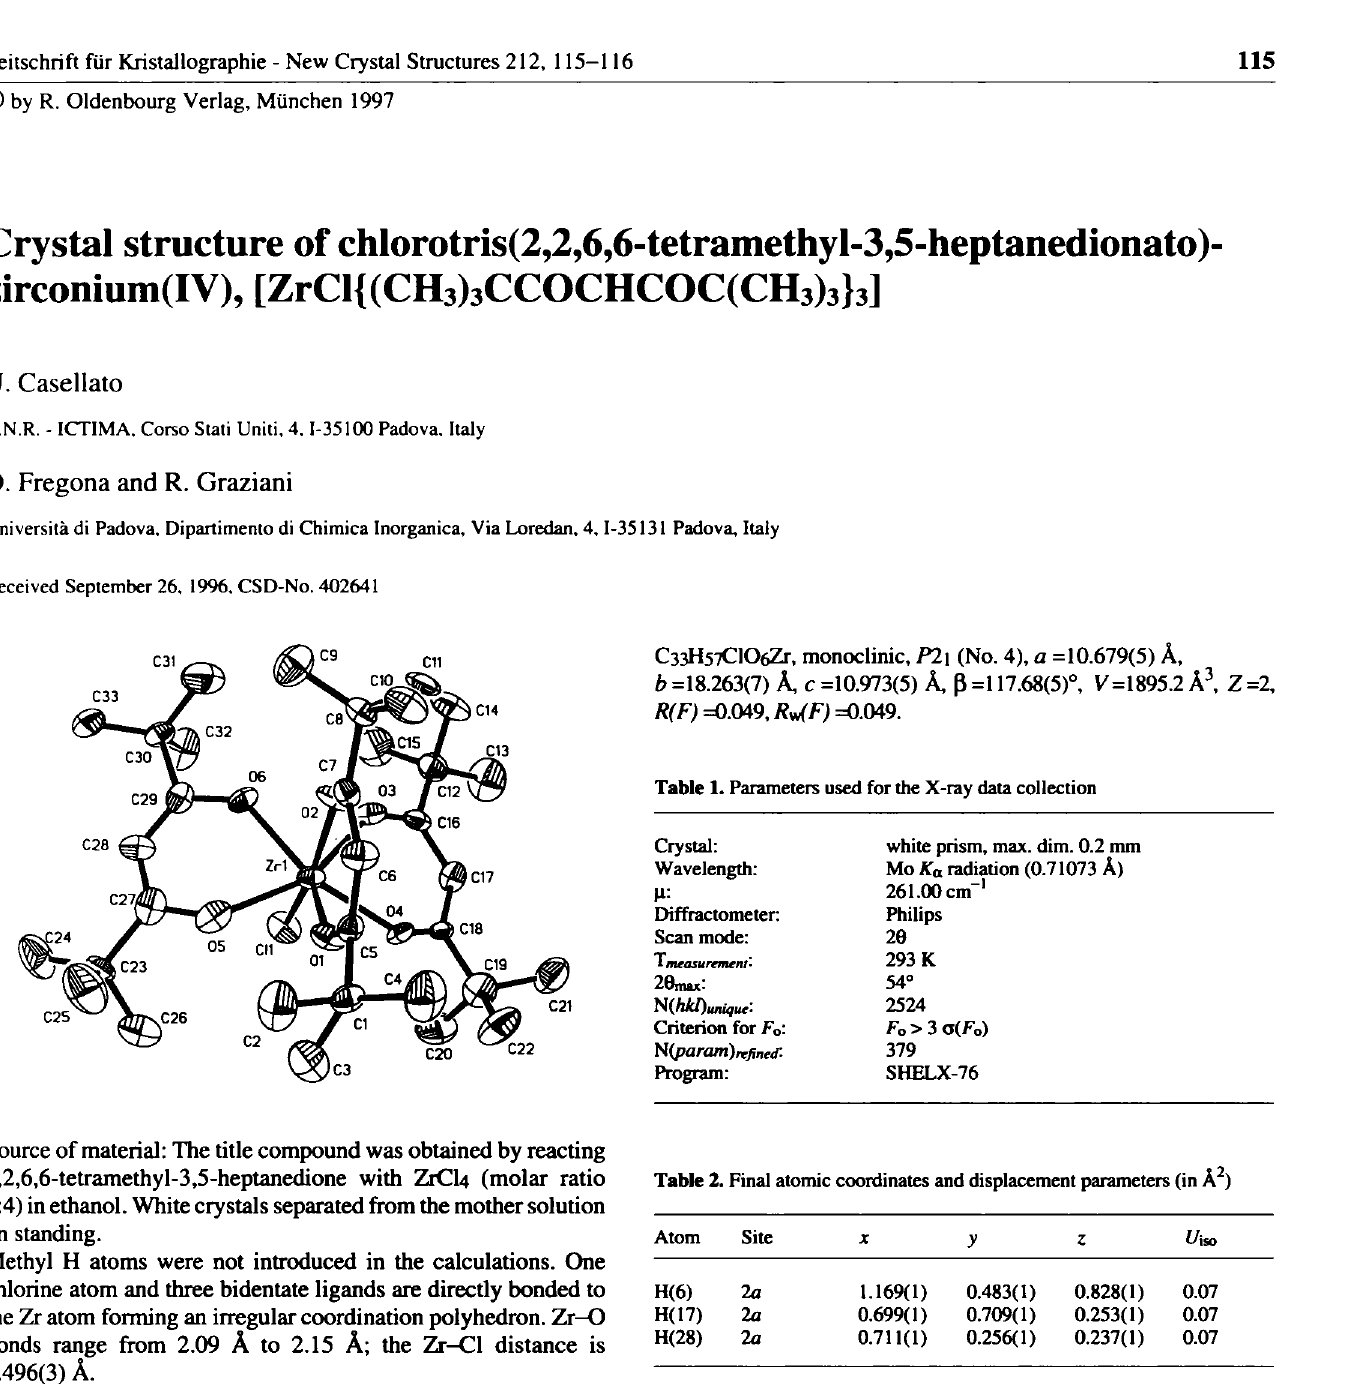
Table 3. Final atomic coordinates and displacement parameters (in Â 2 )